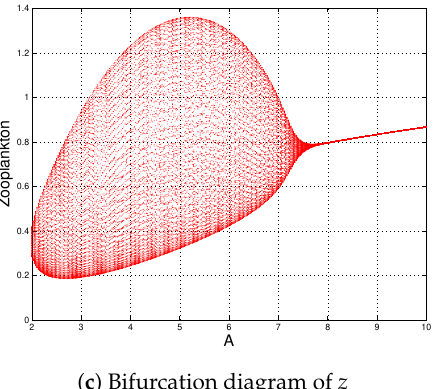
Figure 8. Hopf-bifurcation diagrams of (cid:98) E ( (cid:98) c , (cid:98) p , (cid:98) z ) of system (1) while A varies in the interval [ 2,10 ] and the others remain unchanged as in Figure 6. Here, A = A [ H ] 2 = 7.258206.